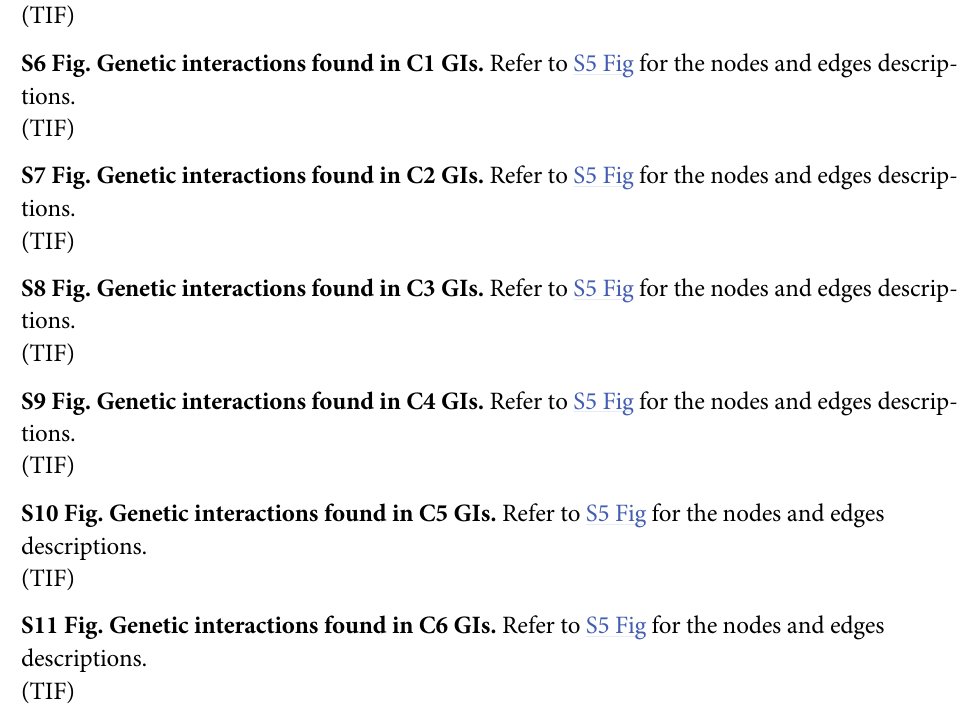
significant enrichments are shown with -Log adjusted P -values ( P < 0.05, see Methods). The 10 GDS size indicates the total number of GIs (edges) of the subnetwork. S4 Fig. Hierarchical clustering of GI classes based on their genes frequencies. Gene frequen- cies are clustered using Binary (left dendrogram) and Canberra (right dendrogram) distance metrics (see Methods). S5 Fig. Examples of genetic interactions from C1 to C6 classes. Nodes represent genes con- nected by genetic interactions from the six classes of GIs. Are also indicated, protein-protein interaction dense subnetworks (PDS) and genes involved in C1 to C6 GIs and also involved in signalling pathways controlling vulval development (S3 Table). S6 Fig. Genetic interactions found in C1 GIs. Refer to S5 Fig for the nodes and edges descrip- tions. S7 Fig. Genetic interactions found in C2 GIs. Refer to S5 Fig for the nodes and edges descrip- tions. S8 Fig. Genetic interactions found in C3 GIs. Refer to S5 Fig for the nodes and edges descrip- tions. S9 Fig. Genetic interactions found in C4 GIs. Refer to S5 Fig for the nodes and edges descrip- tions. S10 Fig. Genetic interactions found in C5 GIs. Refer to S5 Fig for the nodes and edges descriptions. S11 Fig. Genetic interactions found in C6 GIs. Refer to S5 Fig for the nodes and edges descriptions. S12 Fig. Protein-protein interactions degree distribution for the multi-species Caenorhab- ditis elegans interactome. PPI-Hubs are identified as the top 20% most connected proteins in the PPI network indicated by a dashed line. S13 Fig. C7 to C9 classes are enriched in between-pathways interactions. Log-Ratio scores for within-pathway (red bars) and between-pathway (blue bars) relationships observed between genes interacting through unselected GI classes (C7-C10) or present in GIs-all. A posi- tive Log-Ratio score means that the frequency of within- or between-pathway GIs occurring in GI classes is significantly higher than the frequency of similar situations witnessed in relevant randomized GI networks with a probability of 0.99. S14 Fig. Enrichment of within- and between-PDS relationship within pathways is not sig- nificantly influenced by the topology of PDS. (a) Size distribution of 106